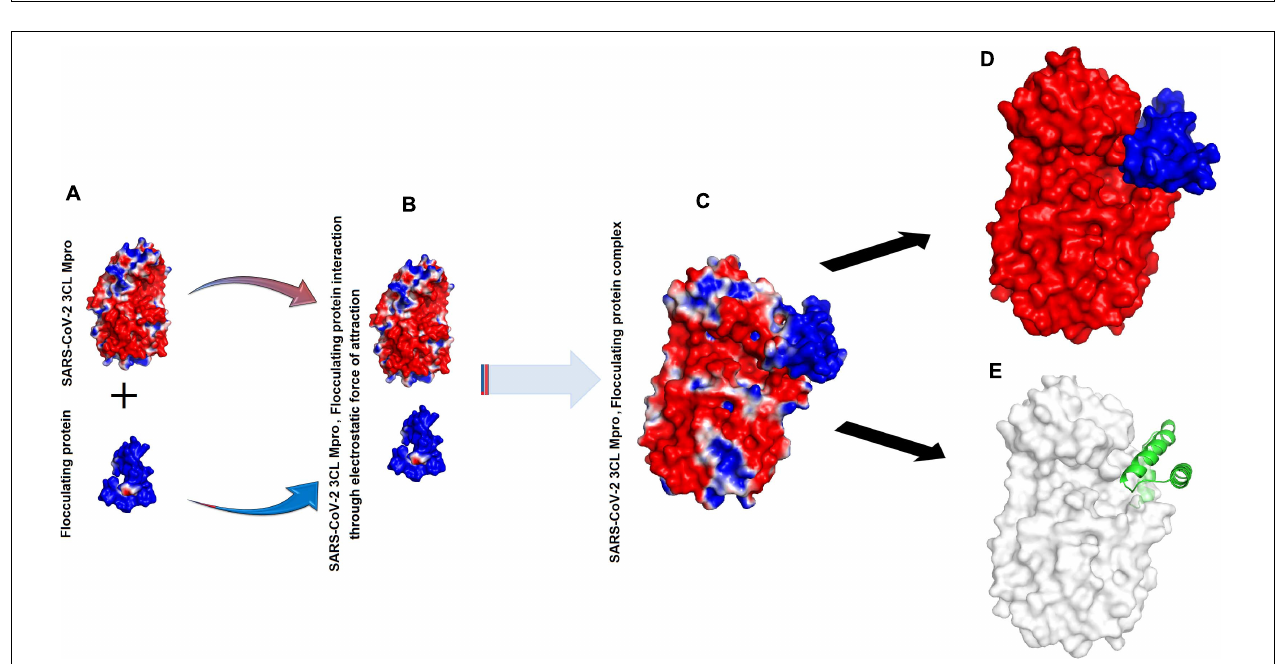
FIGURE 3 | Interaction between SARS-CoV-2 3CL M pro and 2S albumin: (A) Surface charge representation of SARS-CoV-2 3CL M pro and 2S albumin (B) SARS-CoV-2 3CL M pro and 2S albumin approaching each other (C) SARS-CoV-2 3CL M pro , 2S albumin complex (D) 2S albumin (shown as blue surface) residing in the cleft of SARS-CoV-2 3CL M pro between domains II and III (red colored) (E) 2S albumin (shown as green cartoon) interacting with SARS-CoV-2 3CL M pro (shown as white surface).